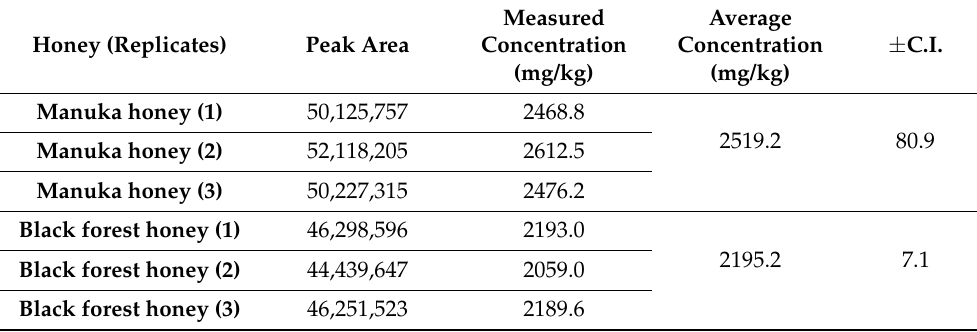
Table 2. Peak area, measured concentration (mg/kg), average concentration (mg/kg), and ± confidence interval (C.I.) for the triplicates of honey samples. Honey (Replicates)